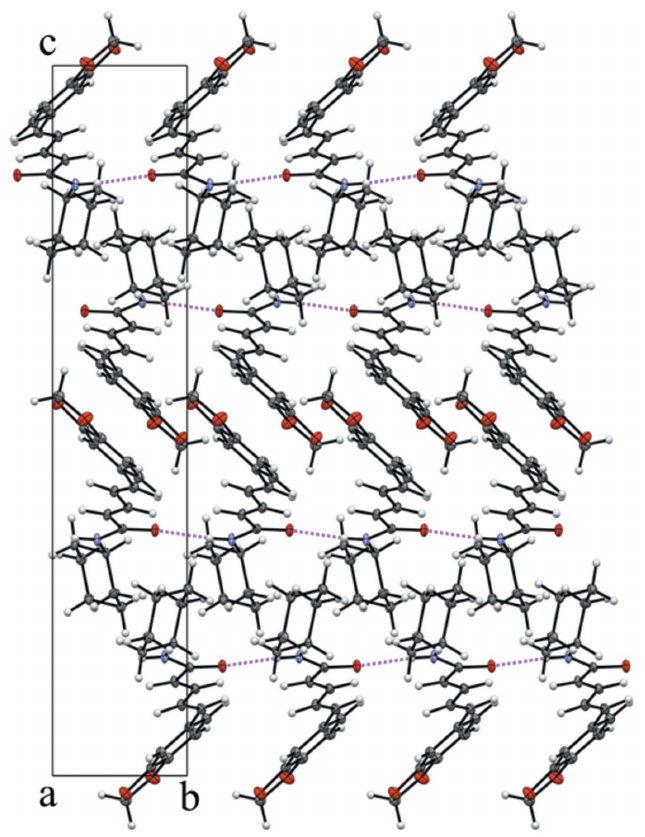
Figure 5 The unit-cell packing for (I) viewed down [100] with hydrogen bonds drawn as dashed lines.